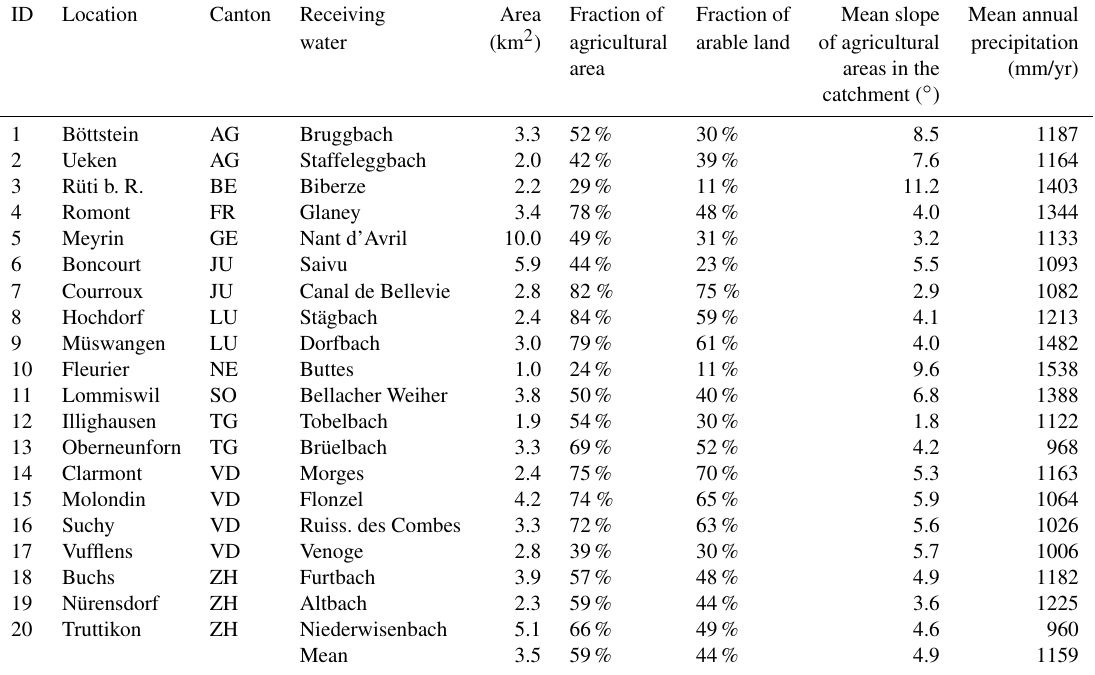
Table 1. Catchment properties of the 20 study areas. Fractions of agricultural area and of arable land were determined from BFS (2014), the mean slope of agricultural areas was determined from BFS (2014) and Swisstopo (2018), and the mean annual precipitation was determined from Kirchhofer and Sevruk